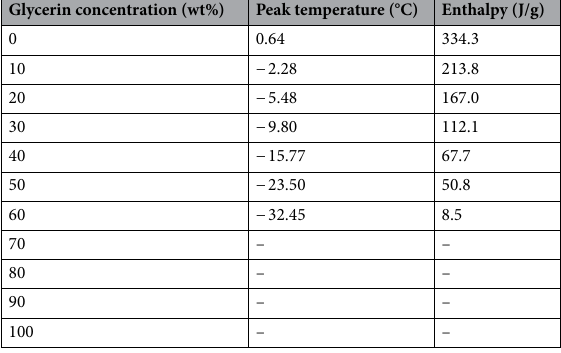
Table 1. DSC thermogram analysis of 0 to 100 wt% glycerin solutions.